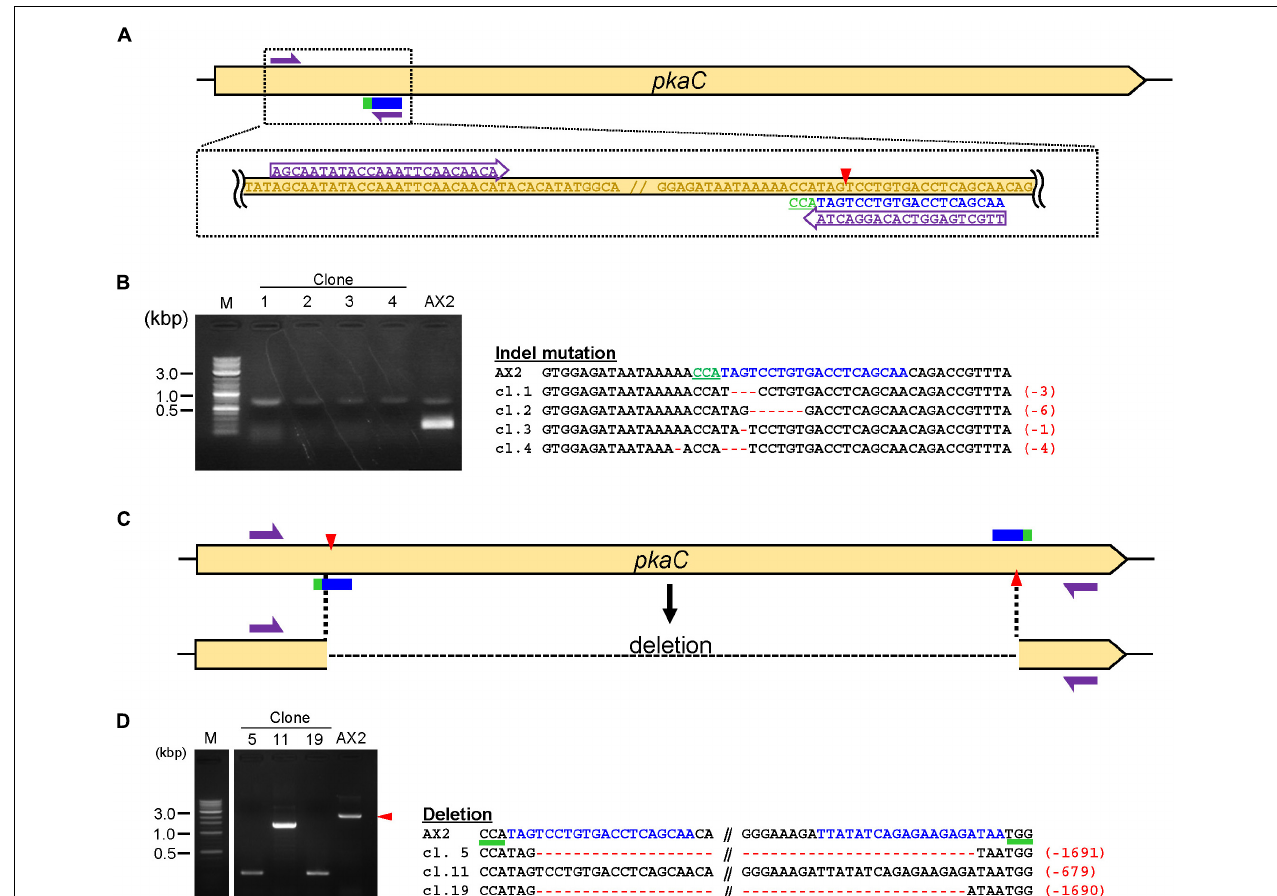
FIGURE 3 | Validation of knock-out and deletion mediated by CRISPR/Cas9. (A) Schematic diagram of the target site for knock-out. Target sequences in pkaC and primers for mutation–detective PCR are shown. (B) Results of mutation–detective PCR and sequencing of the target regions are shown. The PCR products that revealed low amplification compared to the control were candidate mutants. The target sequence is in blue and mutations are in red. Numbers in parentheses indicate the number of modified nucleotides. (C) Schematic illustration of target sites for deletion mediated by Cas9-nickase. (D) PCR and Sequencing results of deletion mutants.The PCR fragments that were different in size compared to the control were deletion mutants.